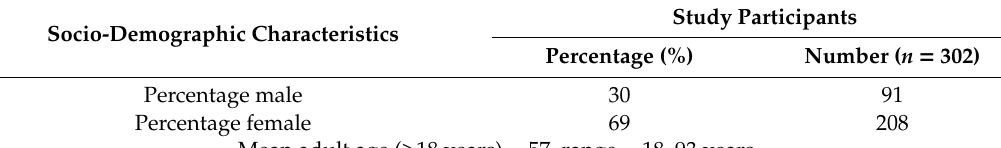
Table 1. Descriptive statistics of Smartline